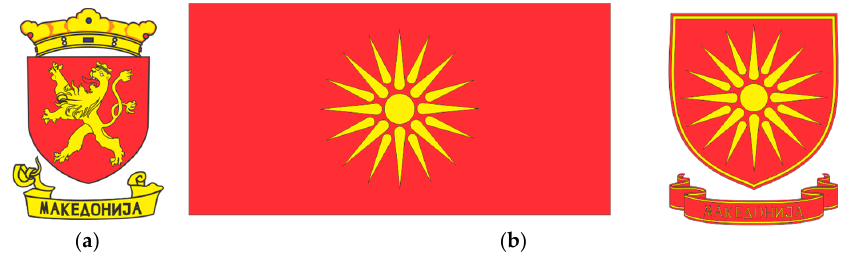
Figure 4. ( a ) Generic proposal of the “Macedonian lion”; ( b ) The proposals by Todor Petrov based on the design of the